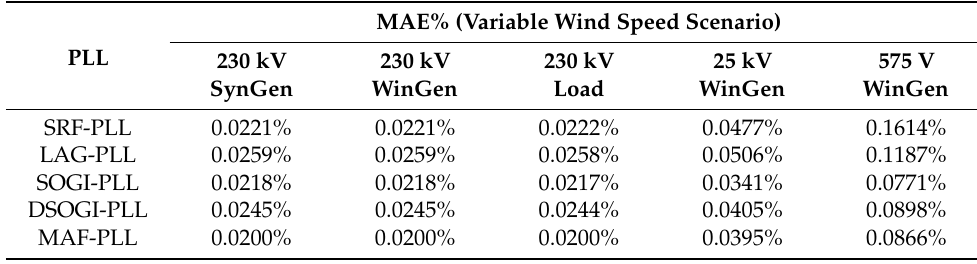
Table 6. Relative mean absolute error for the PLLs located at different buses in the variable wind speed scenario.